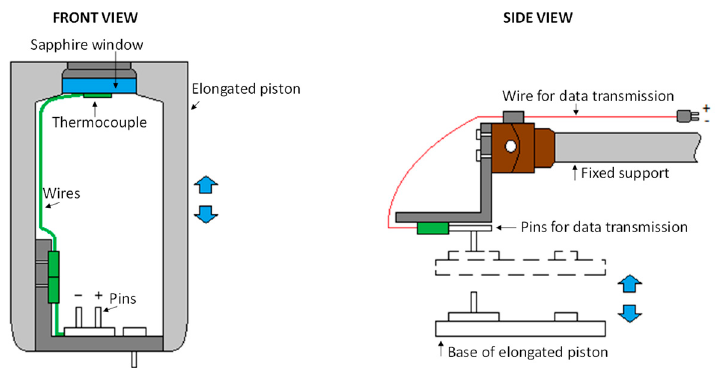
Figure 3. Scheme of the system for the measurement of the piston window temperature [17].